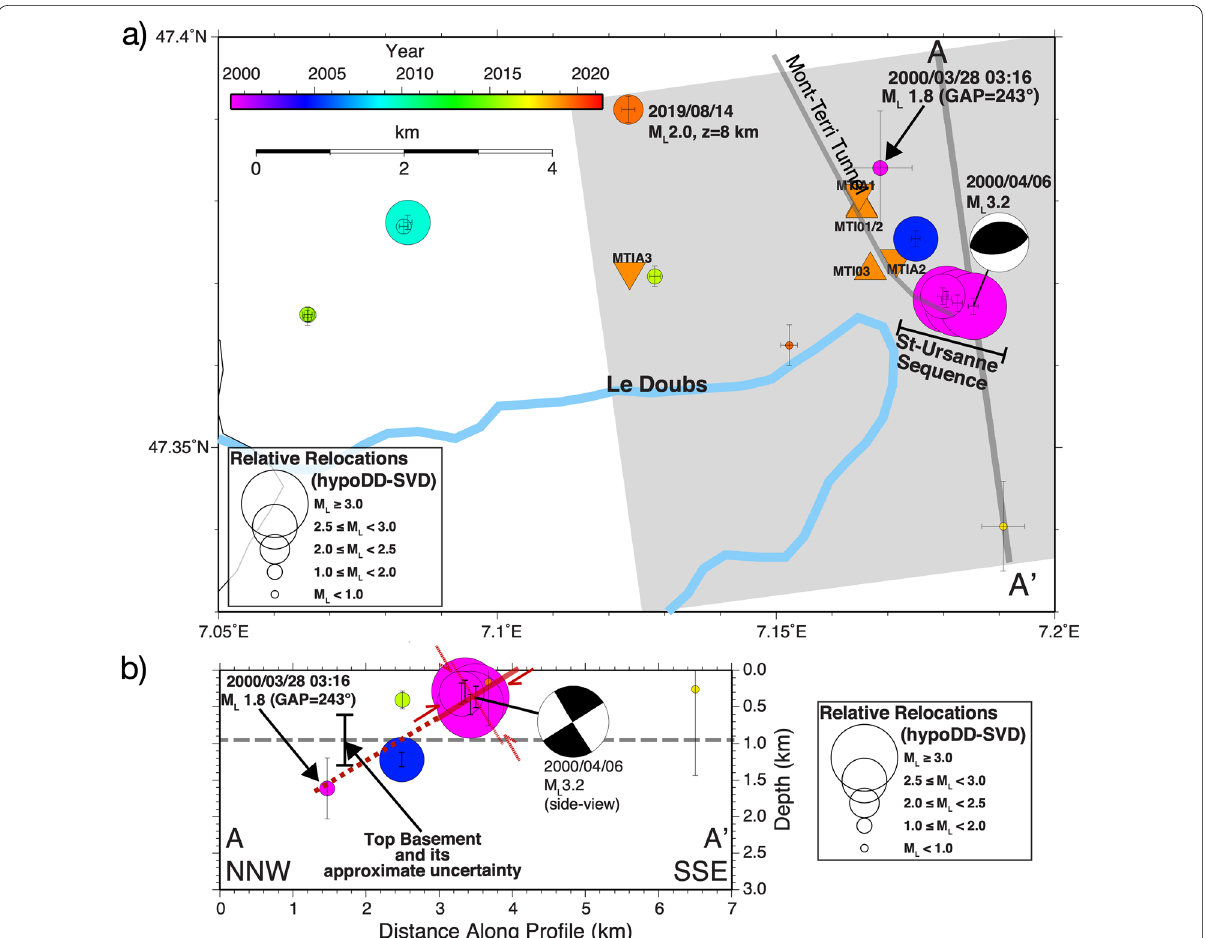
Fig. 5 Relative relocations for shallow earthquakes listed in the SED catalogue from 2000 to 2021 in map view a and along a depth-profile ( b ), oriented perpendicular to the strike of the focal planes. Note that the depth range focuses on the uppermost crust with only events with focal depths < 3 km BSL shown in the profile. No vertical exaggeration has been used for the cross section profile, thus the projection represents true dip angles. Relocations were obtained using the hypoDD algorithm of Waldhauser and Ellsworth (2000) using Singular-Value-Decomposition (SVD) inversion. Error bars indicate the horizontal and vertical relative location uncertainties derived by the SVD inversion. The gray, dashed line indicates the approximate top-basement at ~ 0.9 km depth BSL as inferred by integrating data from geological formations thickness of the area (Nussbaum et al., 2017) as well as the closest borehole logs in the NE (Weber et al., 1986) and in the SW of Saint-Ursanne (Rime et al.,